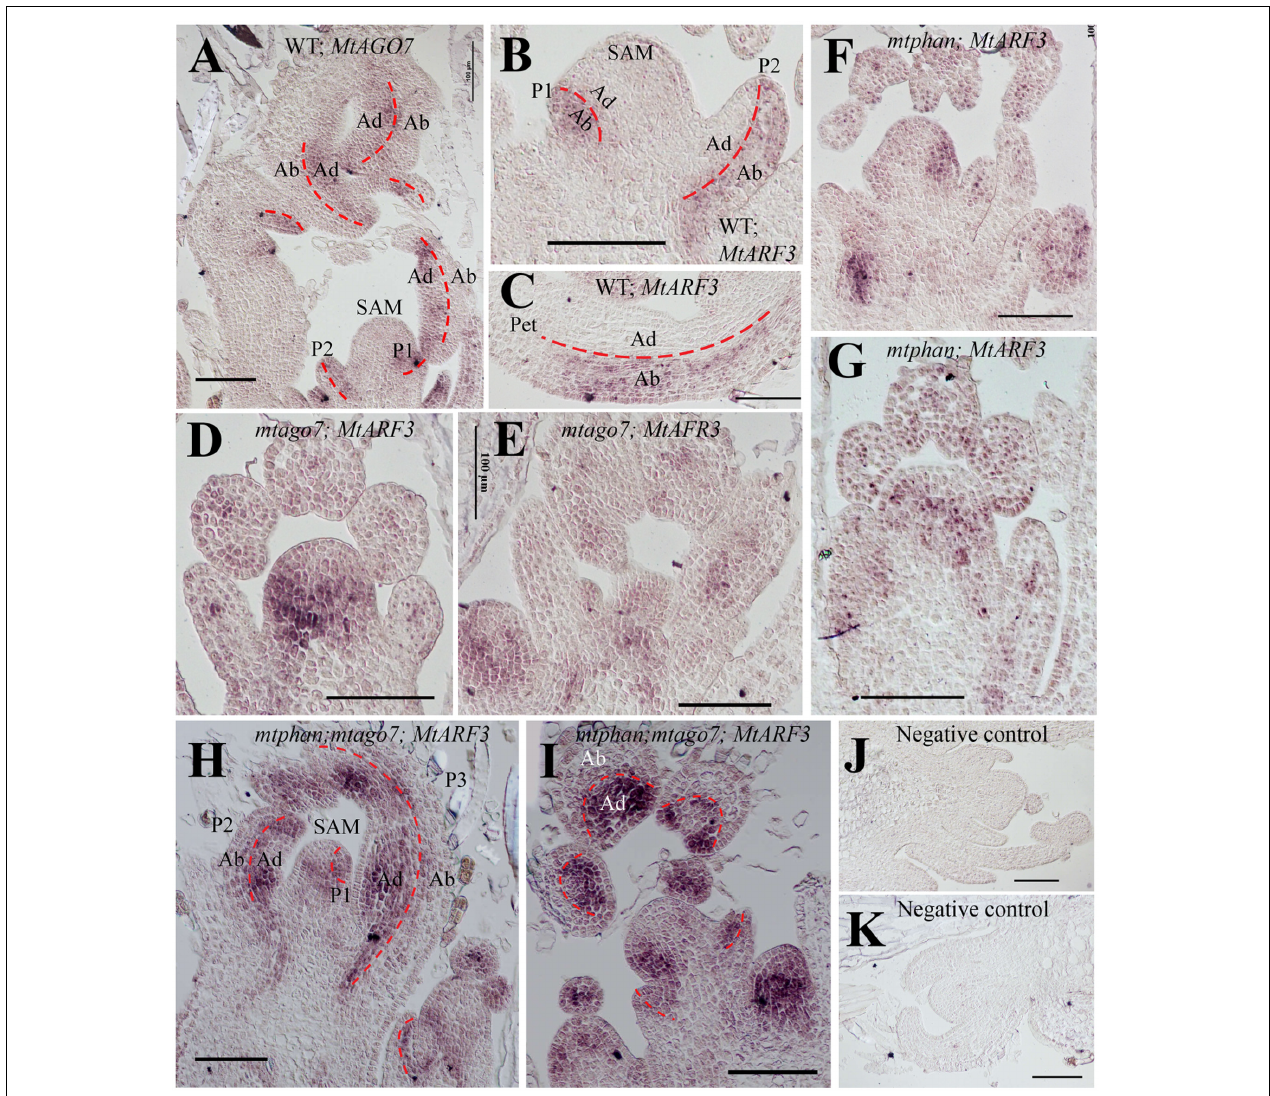
FIGURE 6 | In situ hybridization analyses of MtARF3 and MtAGO7 gene expression in M. truncatula . (A) Localization of MtAGO7 transcripts in vegetative shoot buds in WT. (B,C) Localization of MtARF3 in vegetative shoot bud (B) and petiole of a developing leaf (C) in WT. Note that in wild type plants, MtAGO7 and MtARF3 expressed in opposite domains in leaf primordia, with MtAGO7 being expressed in the leaf adaxial domain and MtARF3 in the leaf abaxial domain. (D,E) Localization of MtARF3 gene expression in mtago7 mutant. MtARF3 gene expression was detected in both abaxial and adaxial domains of leaf primordia in the mtago7 mutant. (F,G) Localization of MtARF3 gene expression in mtphan mutant. MtARF3 gene expression was detected in both abaxial and adaxial domain of leaf primordia in the mtphan mutant. (H,I) Localization of MtARF3 gene expression in mtphan;mtago7 double mutant. MtARF3 gene expression was detected in both abaxial and adaxial domains of leaf primordia in the mtphan;mtago7 double mutant, with stronger signals in the adaxial domain. (J,K) Negative controls using sense probes in neighboring sections for detection of MtAGO7 (J) and MtARF3 (K) . Scale bars: 100 µ m. Dashed lines mark the boundary between the adaxial and abaxial domains. SAM, shoot apical meristem; P, plastochron; Ab, abaxial domain